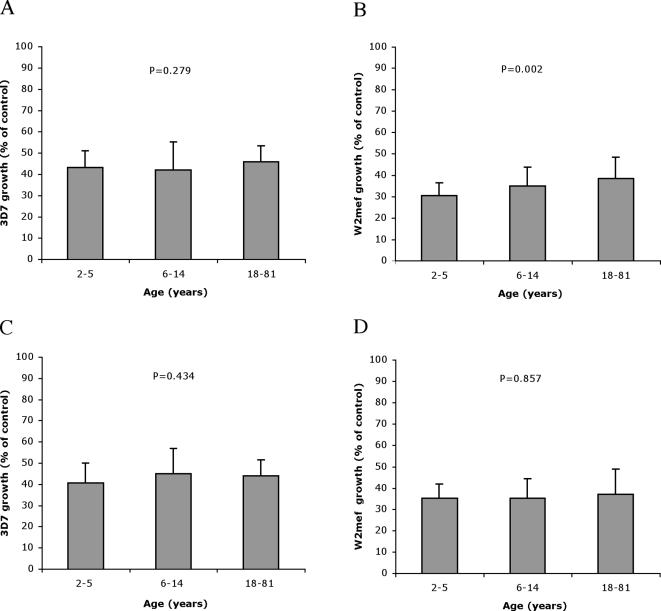

In-vitro growth inhibition of parasite lines 3D7 and W2mef, according to parasitemic status, among samples from the Ngerenya 1998 cohort.A, B: Mean growth of 3D7 and W2mef, respectively, for aparasitemic participants. C, D: Mean growth of 3D7 and W2mef, respectively, for parasitemic participants. Growth is expressed relative to control (PBS). Error bars represent standard deviation. P values were calculated using a one-way ANOVA. All samples were tested in duplicate in two separate assays. For all samples, including parasitemic and aparasitemic individuals together, mean growth (%, ±SD) was: W2mef (n = 138) 31.8±6.5, 2–5 years; 35.1±9.0, 6–14 years; 38.1±10.3, 18–81 years; 3D7 (n = 140) 42.4±8.3, 2–5 years; 44.2±12.4, 6–14 years; 45.4±7.5, 18–81 years.